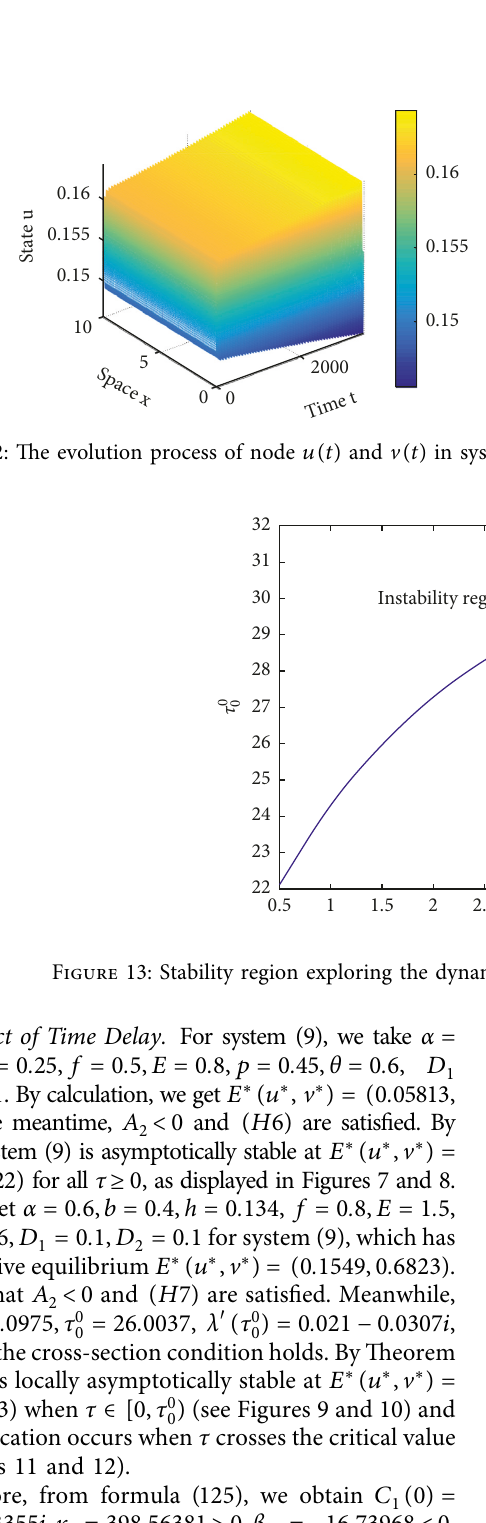
Figure 12: The evolution process of node u ( t ) and v ( t ) in system (9) when D